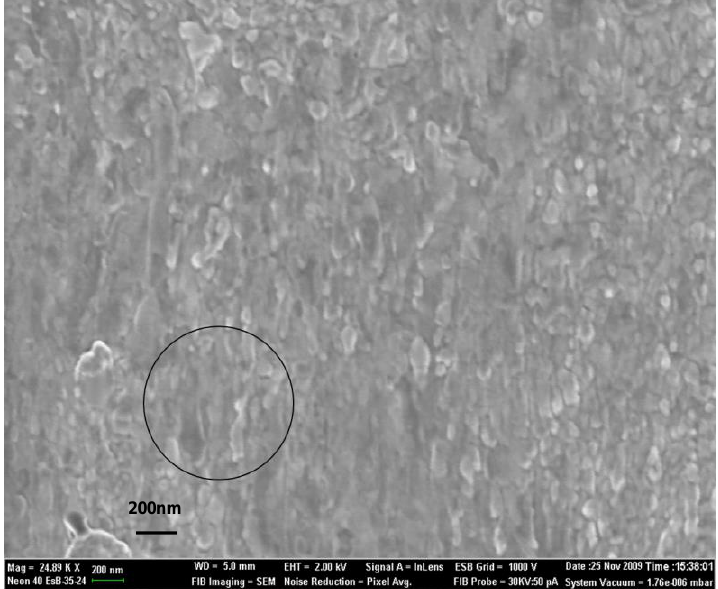
Figure 3. Area of the surface of Cr 56 Al 21 C 23 after laser annealing in HLPD regime. Occurrence of small crystallites is observed. Approximate position of the laser spot is shown.